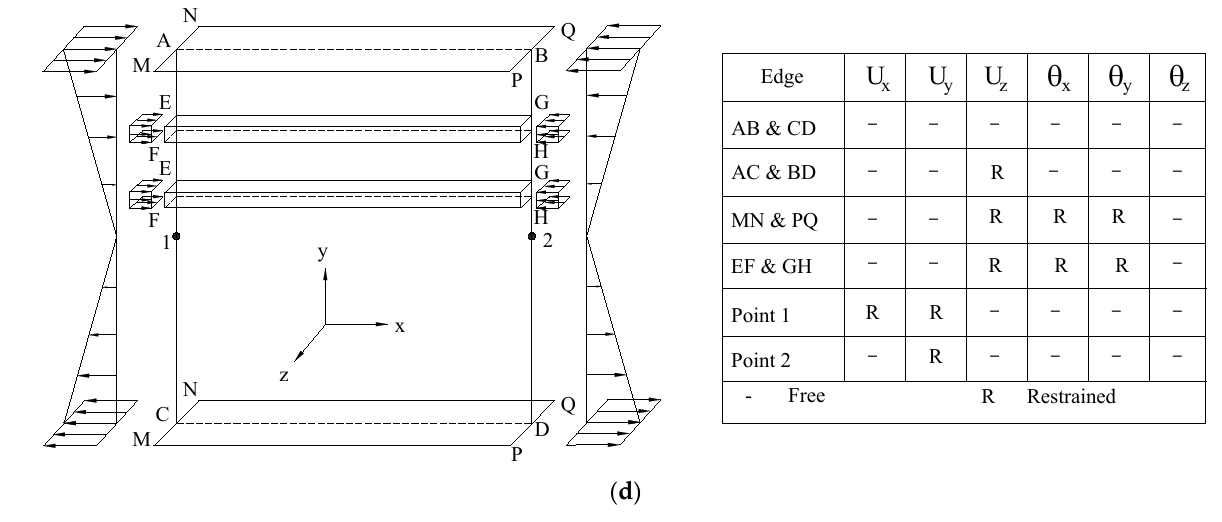
Figure 3. Loading and boundary conditions for various plate girder configurations: ( a ) T section, ( b ) L section, ( c ) triangular section, ( d ) rectangular section.